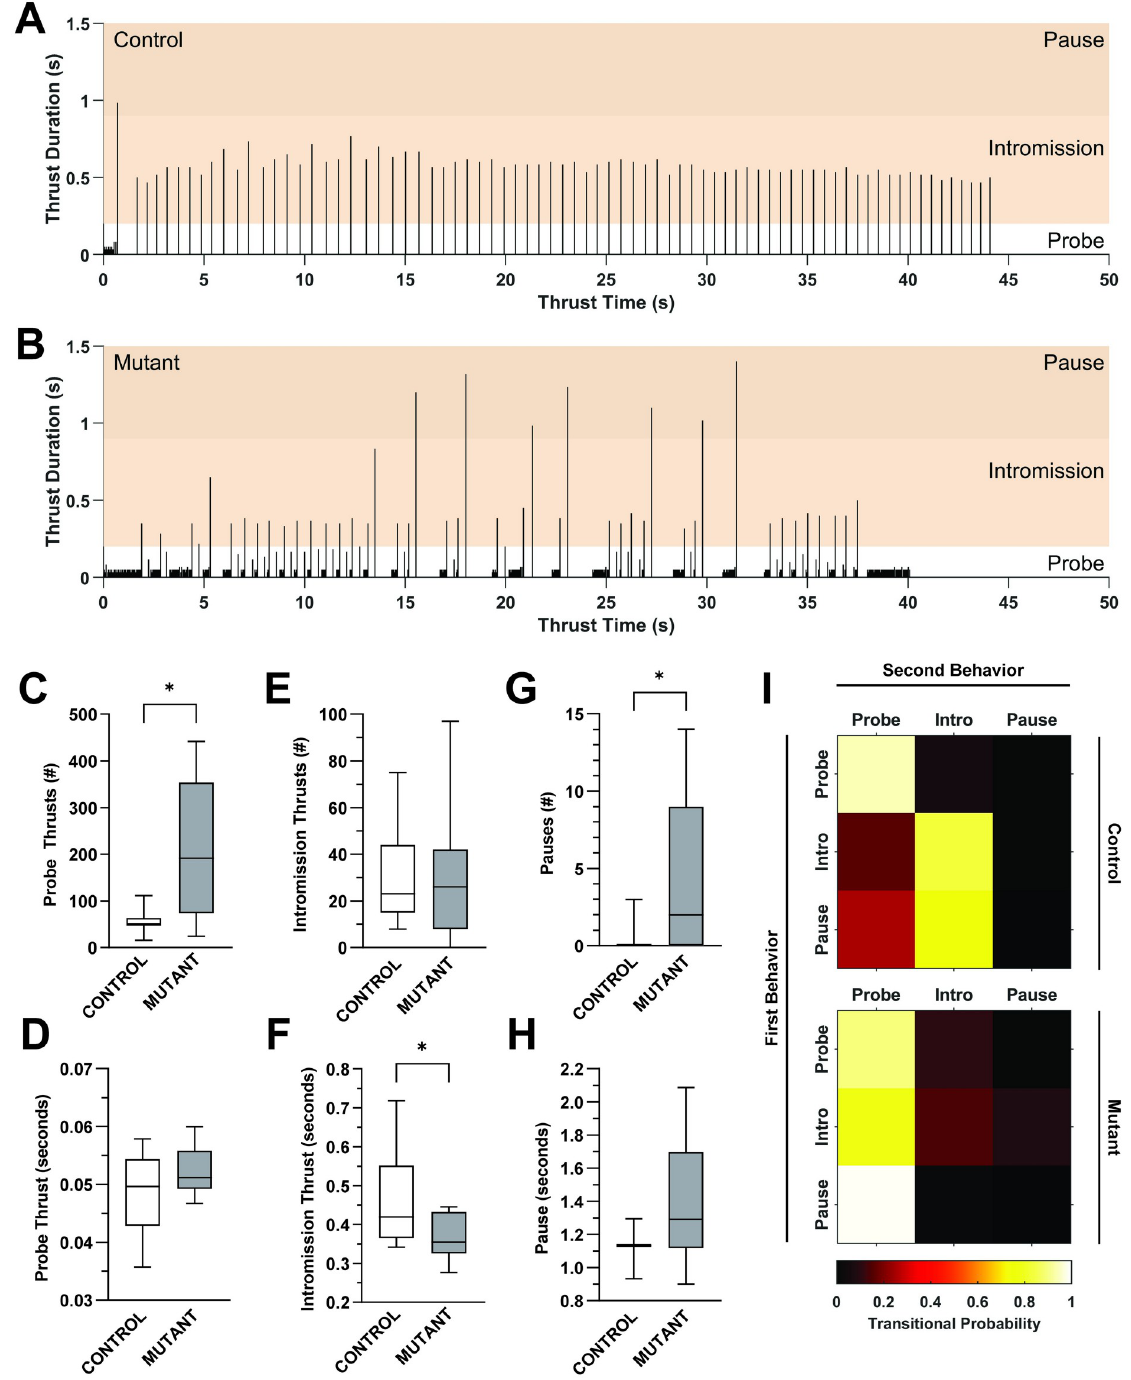
Fig 4. The organization and timing of thrusting behaviors is perturbed in Pea3 null mice. (A and B) Representative thrusting patterns for a single mount for both a control (A) and Pea3 null (C) mouse. Each line indicates a single thrust (duration and timing within the mounting bout). Color boxes indicate categorization of thrusts by thrust duration (probe: < 0.2s; intromission: > 0.2s and < 0.9s; pause: > 0.9s). (C and D) The number of probing thrusts per mount increases in Pea3 null vs control mice (C; control: 57.36 ± 7.884 thrusts, N = 11; null: 211.3 ± 50.25 thrusts, N = 9; Welch’s t test, p < 0.0155, � ), but the mean duration of probing thrusts is unchanged (D; control: 0.048 ± 0.002seconds, N = 11; null: 0.052 ± 0.001 seconds, N = 9; Student’s t test, p < 0.1201, ns). (E and F) The number of intromission thrusts per mount does not change (E; control: 29.45 ± 6.354thrusts, N = 11; null: 29.44 ± 9.881, N = 9; Mann-Whitney test, p < 0.8235, ns), however, the mean duration of intromission thrusts is shorter in Pea3 null vs control mice (F: control: 0.460 ± 0.034seconds, N = 11; null: 0.369 ± 0.020, N = 9; Mann-